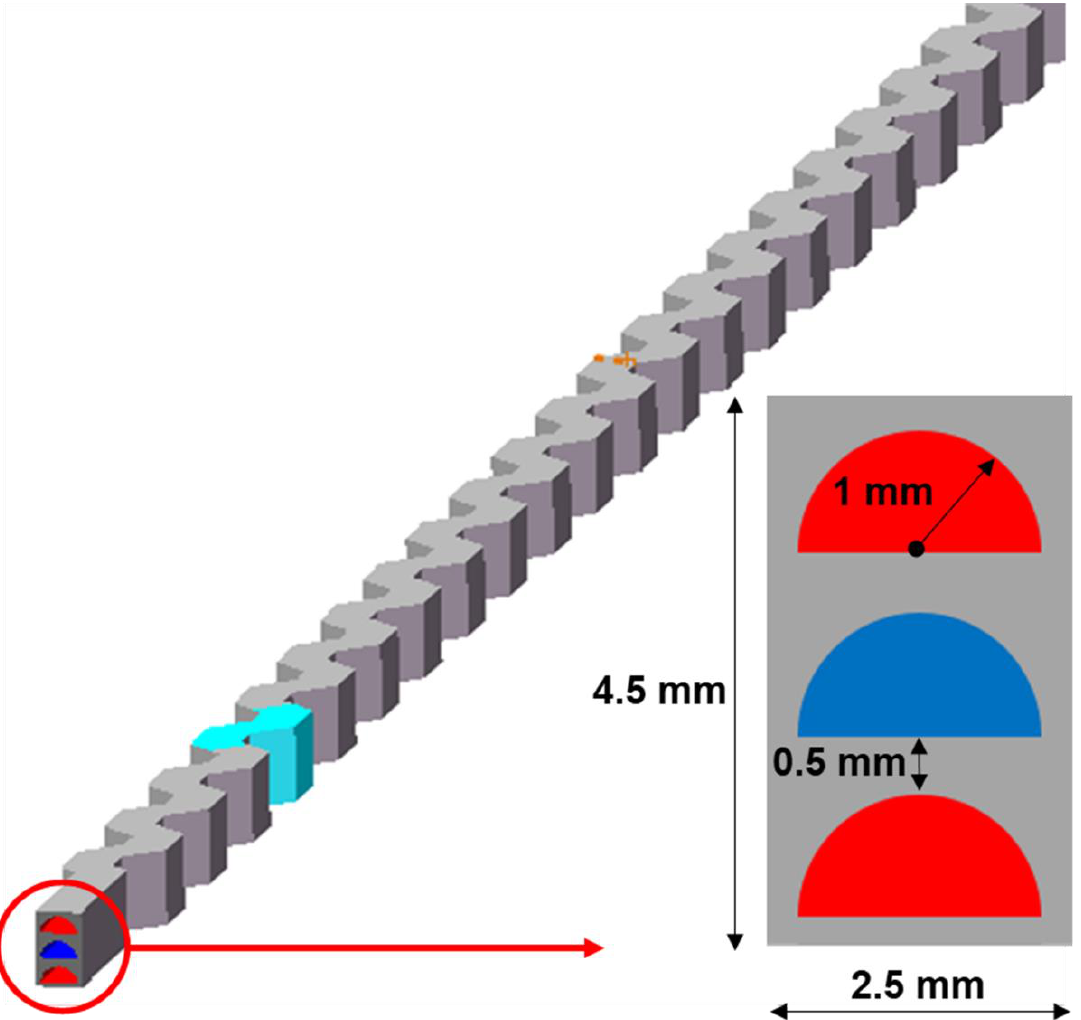
Figure 7. The three-channel model of one cold channel sandwiched between two hot channels. The comparison of pressure loss between the optimized structure and the original design is presented in Table 6. The inlet pressure and temperature conditions are the same with previous simulations, that is 388.75 K, 20.2 MPa in the cold side and 726.85 K, 7.6 MPa in the hot side. The mass flow rates in all cold sides are 14.45 × 10 − 3 kg/s, 9.63 × 10 − 4 kg/s, and 7.23 × 10 − 4 kg/s, corresponding to the Reynolds number of 33,366, 22,244, and 16,683, respectively. As for the hot side flow, it is the same with the cold side in the double-channel structure, and half of the cold side in the sandwich structure because there are two hot channels. Significant reductions in pressure drop loss in the hot channel are obtained, where the values are 75.4% (from 154.81 kPa to 38.37 kPa) and 74.7% (from 39.65 kPa to 10.05 kPa) at 42 kPa and 11 kPa pressure loss cases in the cold side, respectively. The sandwich structure also shows a higher regenerative efficiency, as shown in Figure 8, where the values are increased by 5% at all same length and mass flow conditions.